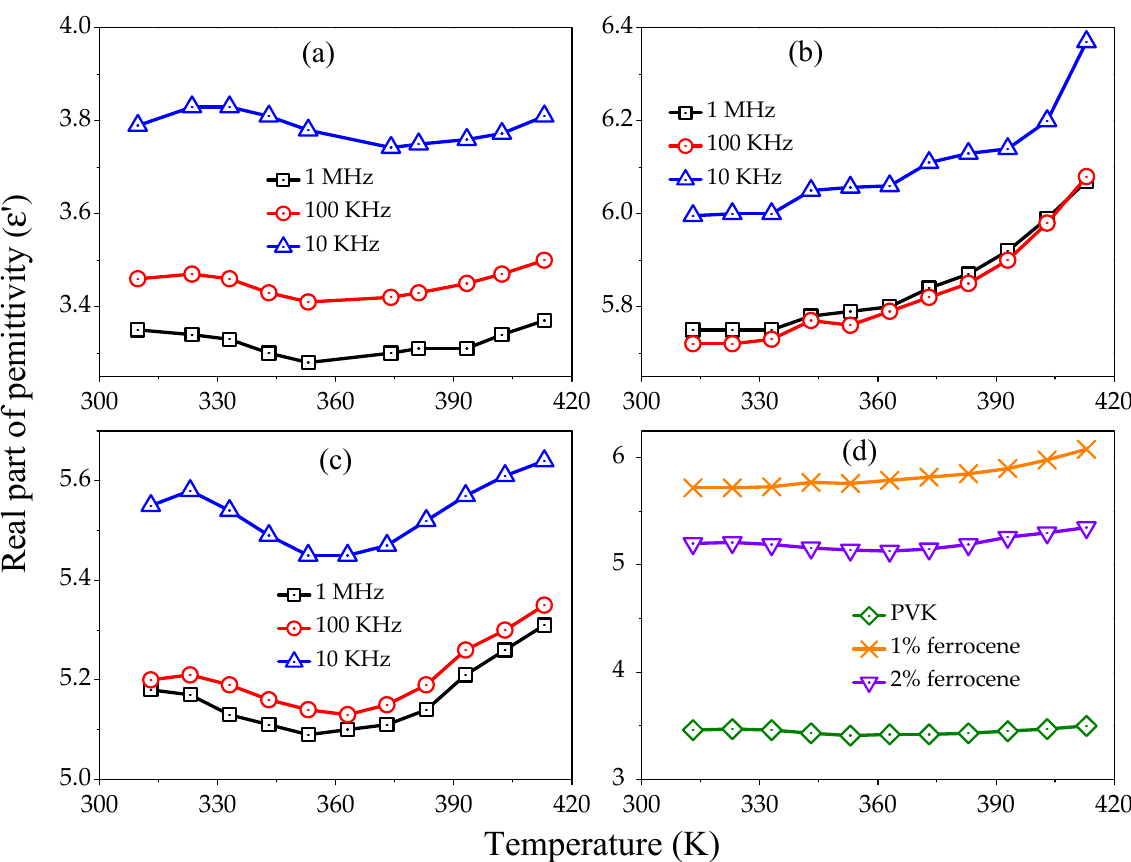
Figure 3. Variation of real part of dielectric constant ( 𝜀 (cid:4593) ) as function of temperature for ( a ) pure PVK, ( b ) 1% ferrocene doped PVK, ( c ) 2% ferrocene doped PVK, and ( d ) at frequency of 100 kHz for pure and doped PVKs.